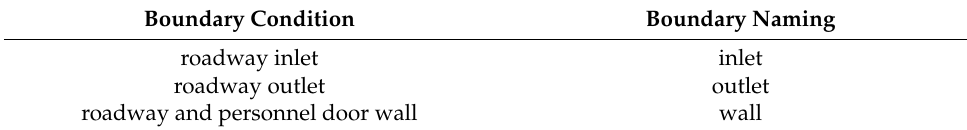
Table 6. Model boundary conditions.